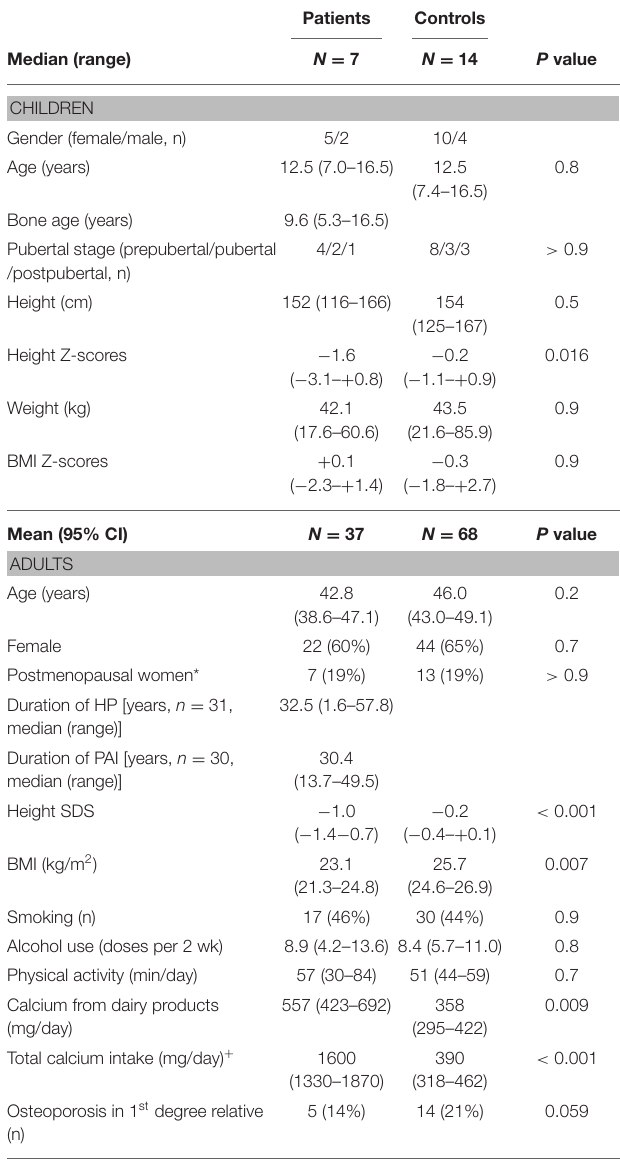
TABLE 2 | Characteristics in the pediatric and adult patients with APECED in comparison with age- and gender-matched control subjects. Patients